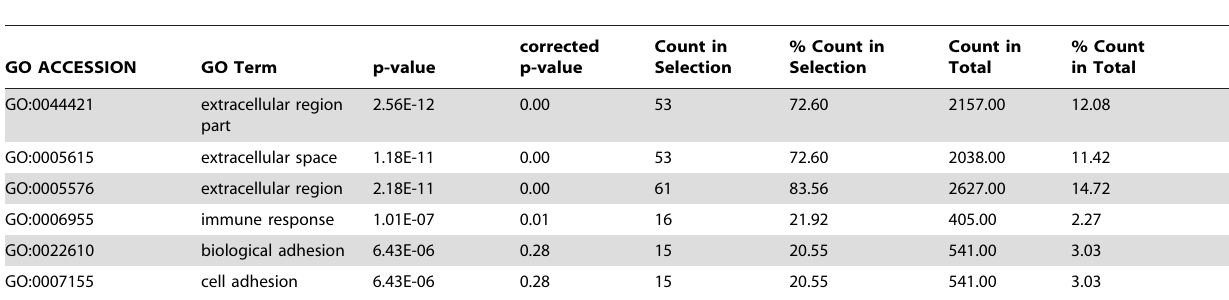
Table 6. GO Analysis of the genes differentially regulated between the Mta1 -KO and Mta1 - KO/Mta1 probes with $ 2.0 fold change.